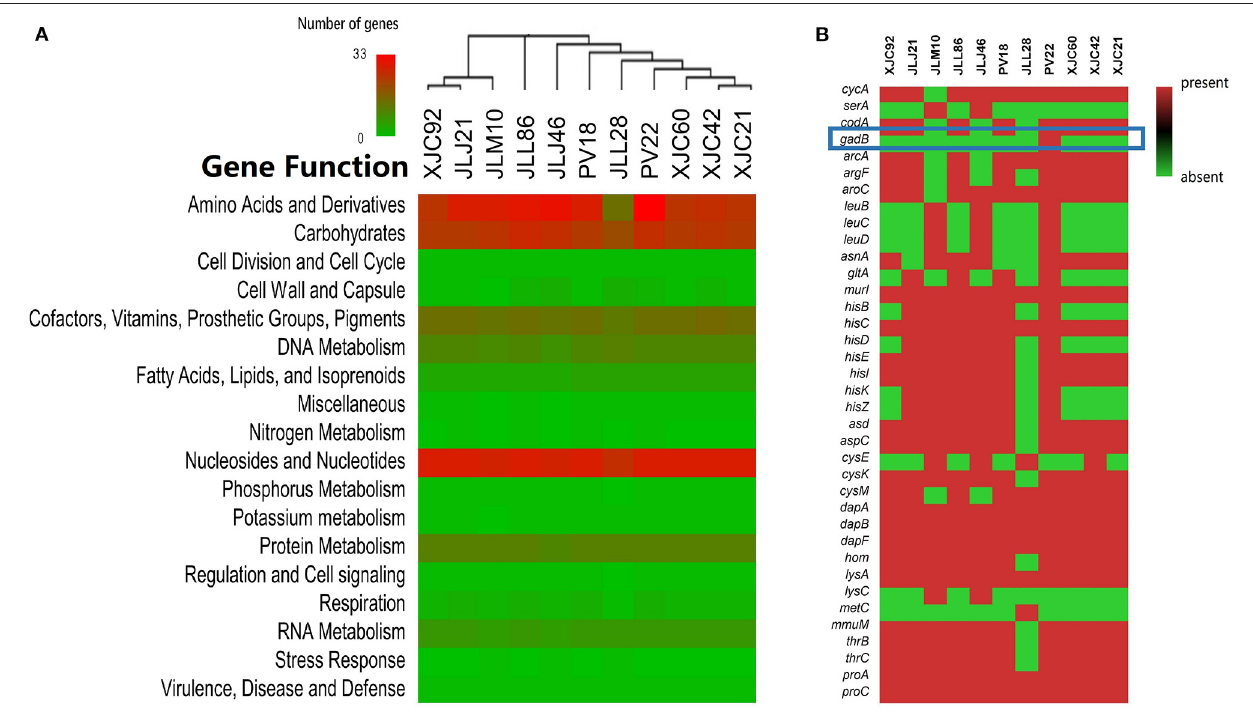
FIGURE 4 | Genome mining of antiviral mechanisms of Limosilactobacillus fermentum PV22. (A) Gene distributions in different L. fermentum isolates. L. fermentum PV22 showed high abundance in gene processing, especially in amino acids and derivatives. (B) The presence/absence of genes that encode functional amino acids and derivatives. gadB is highlighted using a blue square in the heatmap; it is an L. fermentum PV22 strain-specific gene.